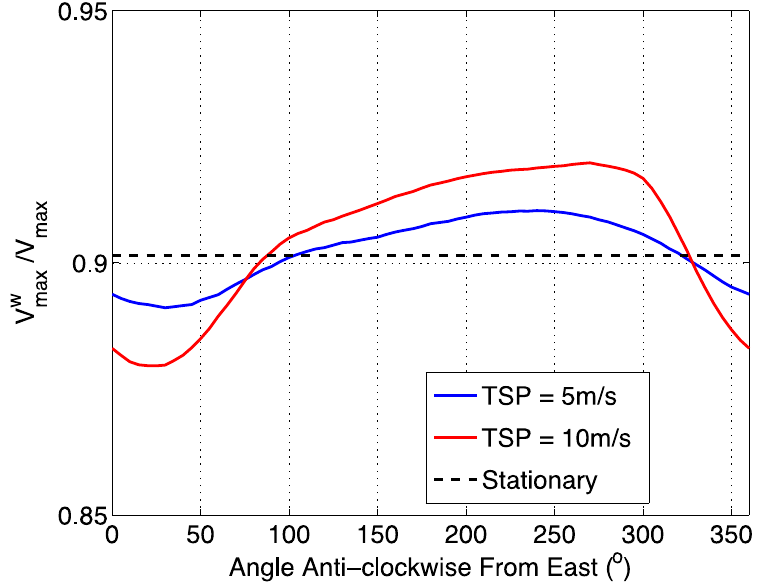
Figure 4. The ratio of 𝑉 𝑚𝑎𝑥𝑤 to 𝑉 𝑚𝑎𝑥 at every 5 degrees around the eyewall anti-clockwise from the east. The blue and red lines represent results from experiment C with TC translation speed of 5 and 10 m/s. The dashed black line gives results from experiment A with RMW = 70 km.